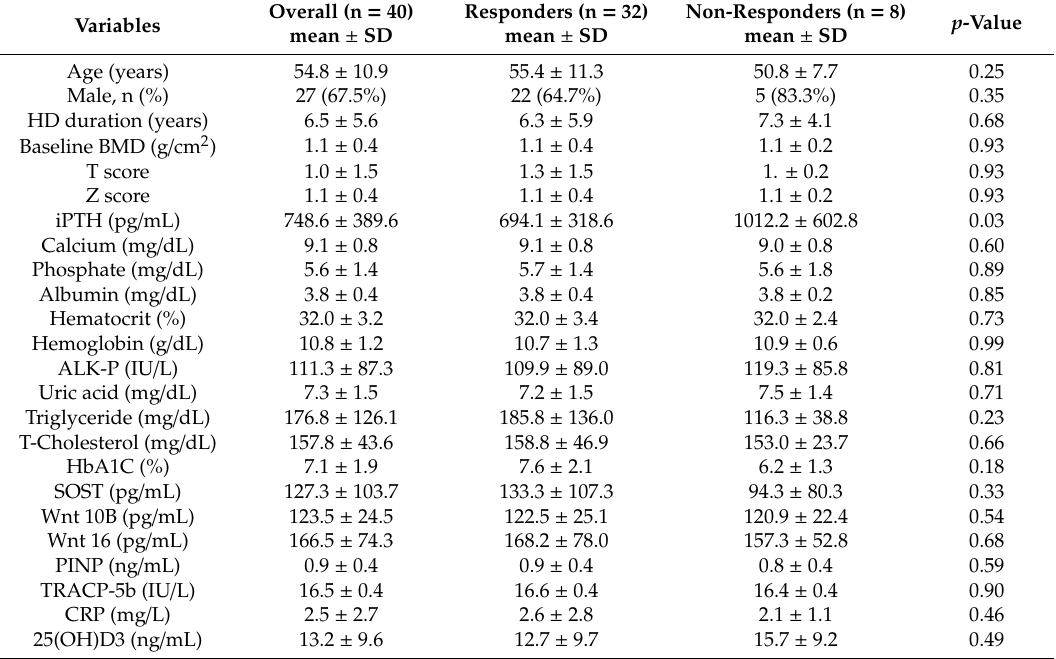
Data are expressed as the mean ± SD or n (%). Boldface indicates where the values di ff er significantly between responders and non- responders. Quantitative data were analyzed with a non-paired Student’s t -test. 25(OH)D3,